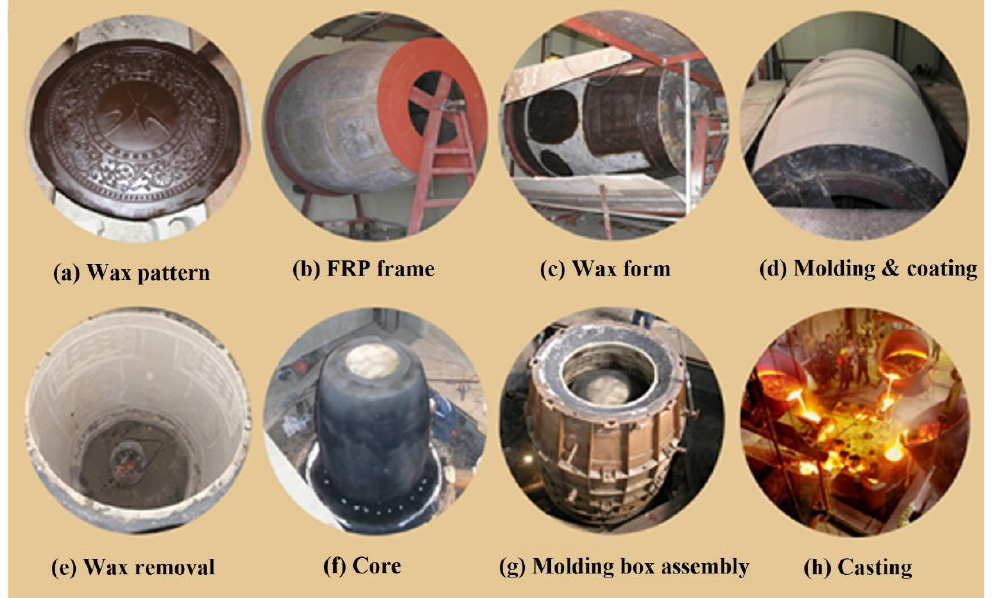
Figure 10. The LWC method used to produce a temple bell. ( a ) Wax pattern, ( b ) FRP frame, ( c ) wax form, ( d ) molding and coating, ( e ) wax removal, ( f ) core, ( g ) molding box assembly, and ( h ) casting [122].